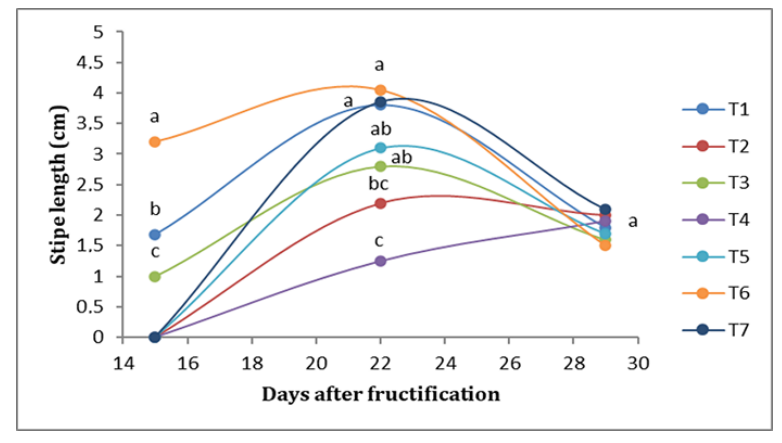
Figure 4 Stipe length profile as a function of time.